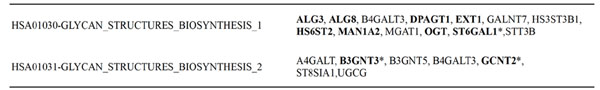
Genes involved in two glycome biosynthesis pathways The genes found in the expression signature are indicated by bold characters. Three genes related to glycan transfer are indicated by asterisks.